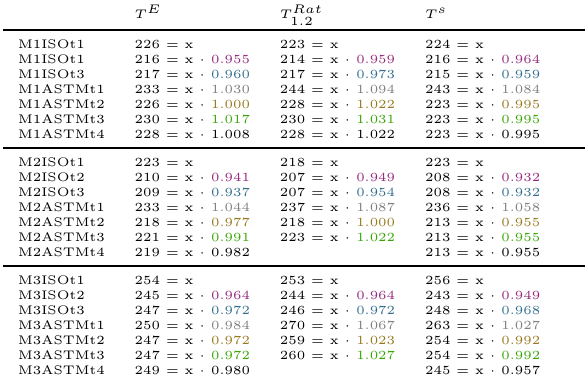
Table 4. Determination of individual shift factors (all values in Kelvin).